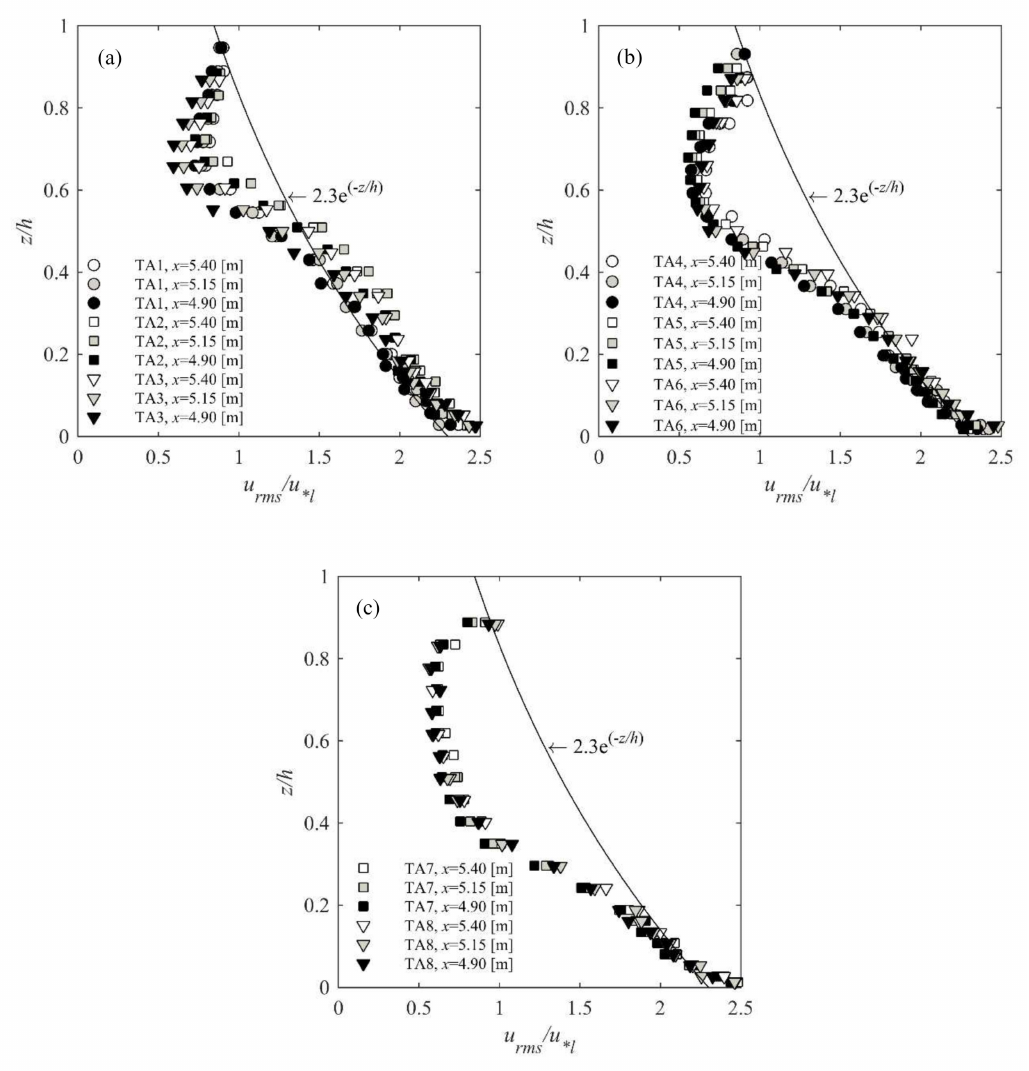
Figure 9. Normalized streamwise turbulence intensity profiles for ( a ) TA1–TA3, ( b ) TA4–TA6, ( c ) TA7–TA8 in all cross-sections and universal fit